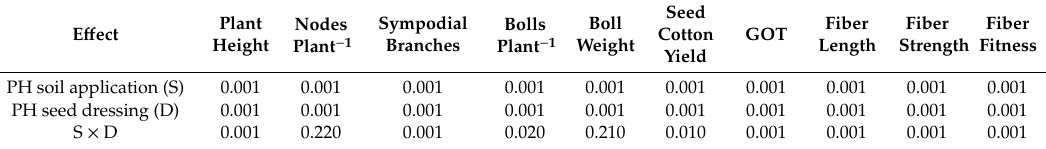
Table 2. The main interactive e ff ects of soil and seed dressing potassium humate on cotton growth, yield and fiber quality attributes at p < 0.05. Plant E ff ect